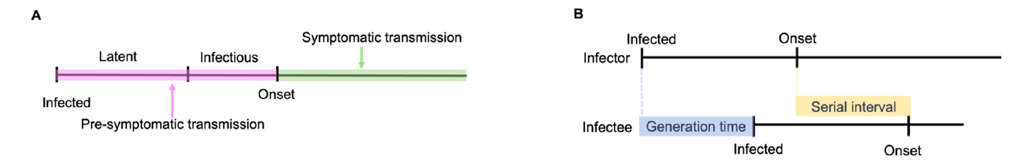
Figure 1. The demonstrative timeline of transmission and symptom onset. ( A ) Timeline of pre- symptomatic and symptomatic transmissions; ( B ) Graphical interpretation of the generation time and serial interval using the timeline of transmission chain for an infector and infectee pair.